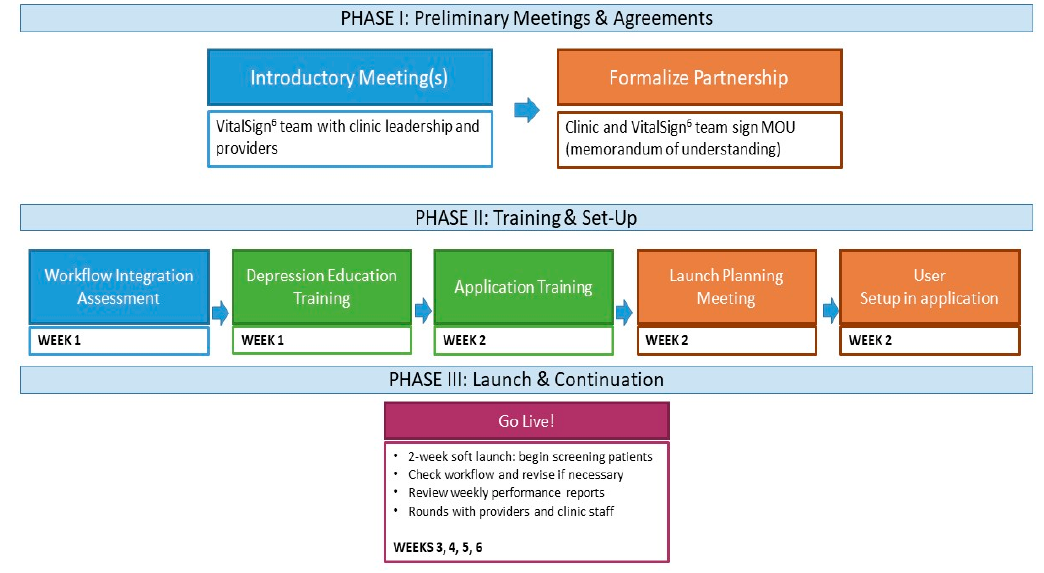
Figure 3. VitalSign 6 Launch Process.